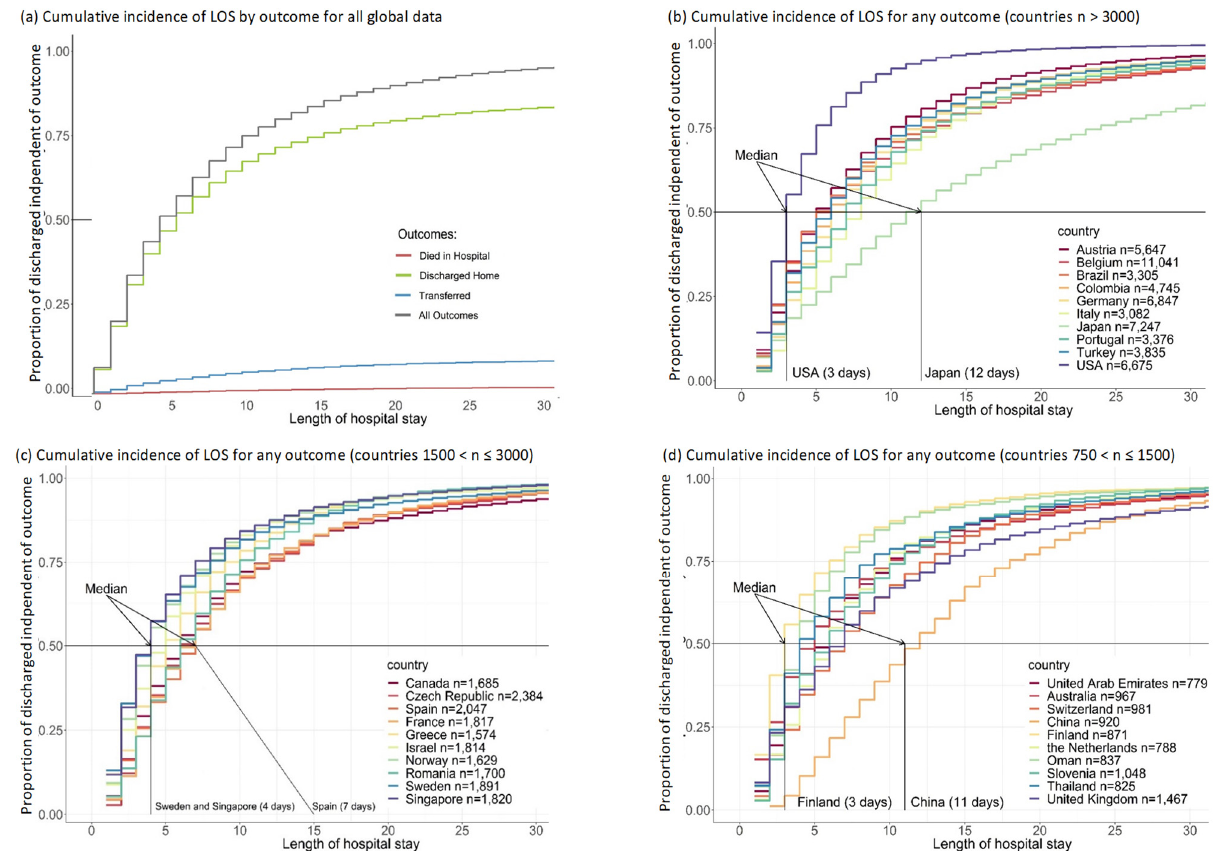
Figure 3. Cumulative incidence graphs for global data and per groups of 10 countries (adjusted for length bias) including figure ( a ) for the global data and figure ( b ) for countries with n > 3000; figure ( c ) for countries with 1500 < n ≤ 3000; figure ( d ) for countries with 750 < n ≤ 1500.